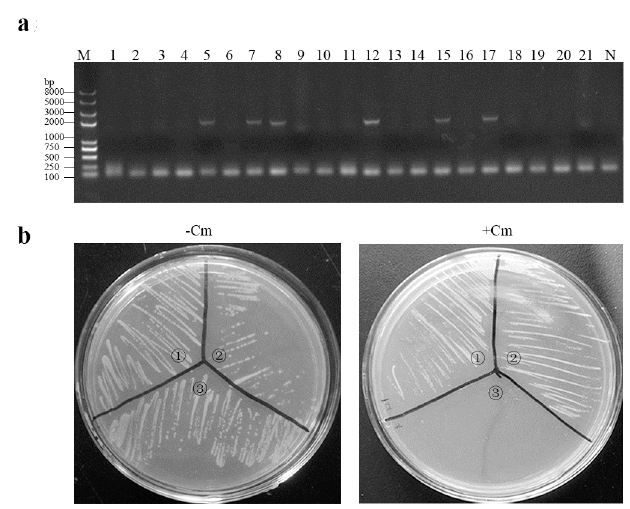
Figure 2. The identification of recombinant Lactobacillus strain rLpPG F -T7g10-eGFP-6D-COE without antibiotic resistance. ( a ) Recombinant strains with green fluorescence signal were collected, spread on an de Man-Rogosa-Sharpe (MRS) plate, and confirmed by colony PCR (Fe and Rs2 as primers). Lane M: Trans2K plus II DNA marker; lanes 1–21: colonies; lane N: negative control; ( b ) the results of chloramphenicol sensitivity assay. ① rLpPG-T7g10-6D-COE; ② rLpPG-T7g10-6D-COE; ③ rLpPG F -T7g10-eGFP-6D-COE.